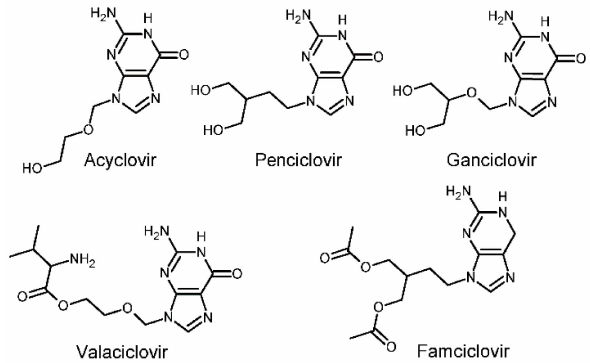
Figure 1. Molecular diagrams of the five most known guanosine nucleoside analogues used as